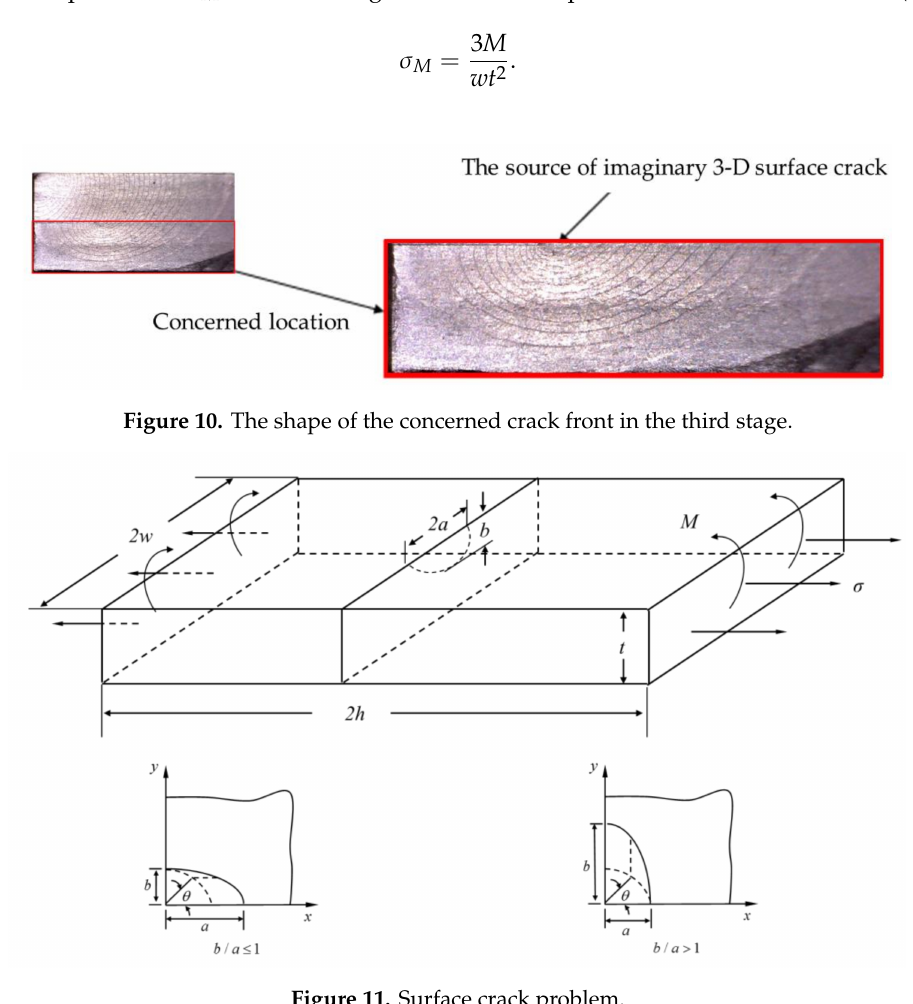
Figure 11. Surface crack problem.